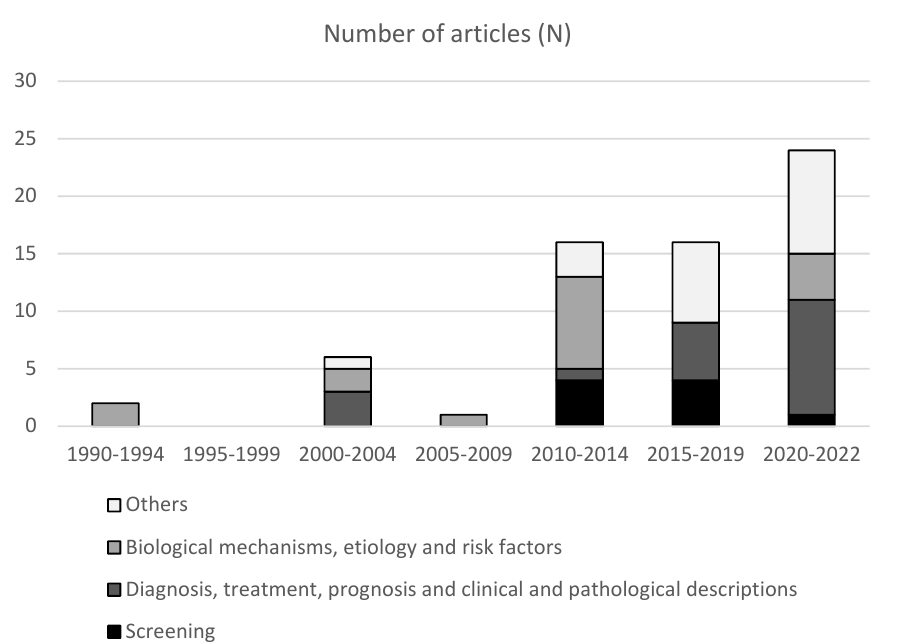
Figure 2. Number of articles published in PubMed ® from 1990 to 2022, according to the main topic Data were reported in periods of five years, except for the last category (2020–2022) where a period of three years was used.